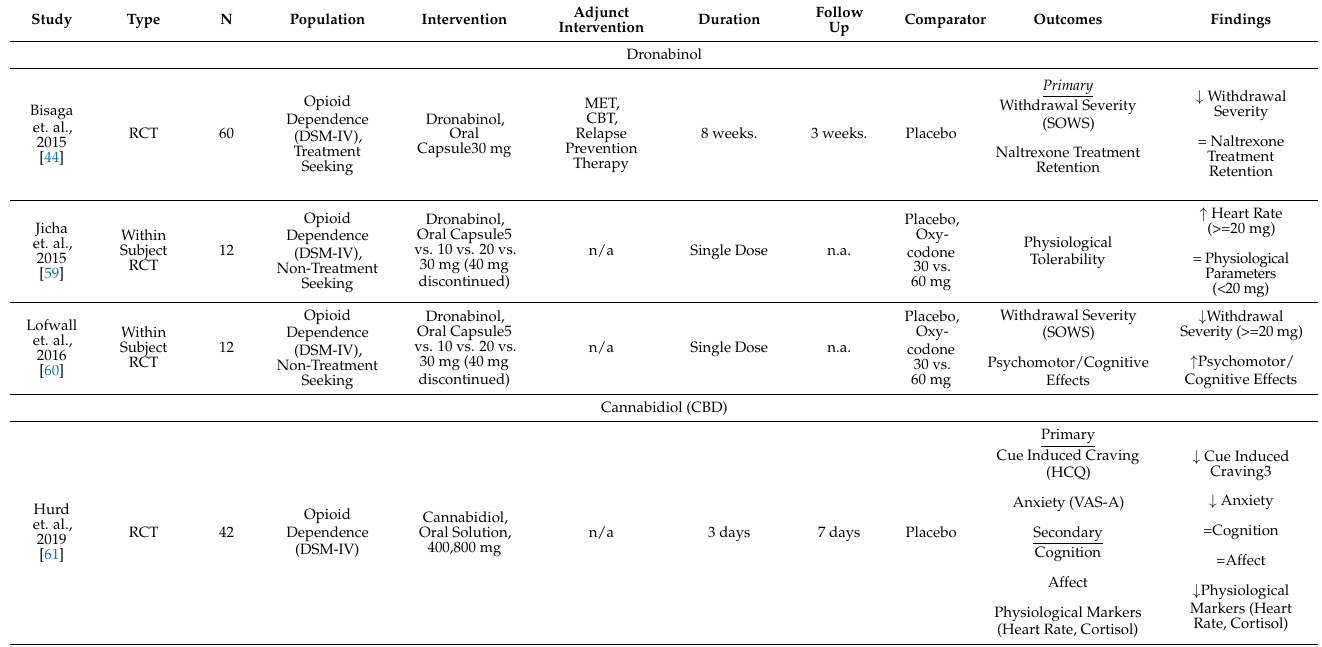
Table 4. Primary Studies pertaining to Opioid Use